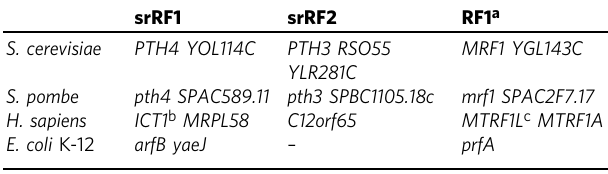
Table 1 Summary of gene names of two stalled-ribosome rescue factors (srRFs) and one release factor (RF1), all of which have the GGQ motif, in mitochondria of four eukaryotes and E. coli